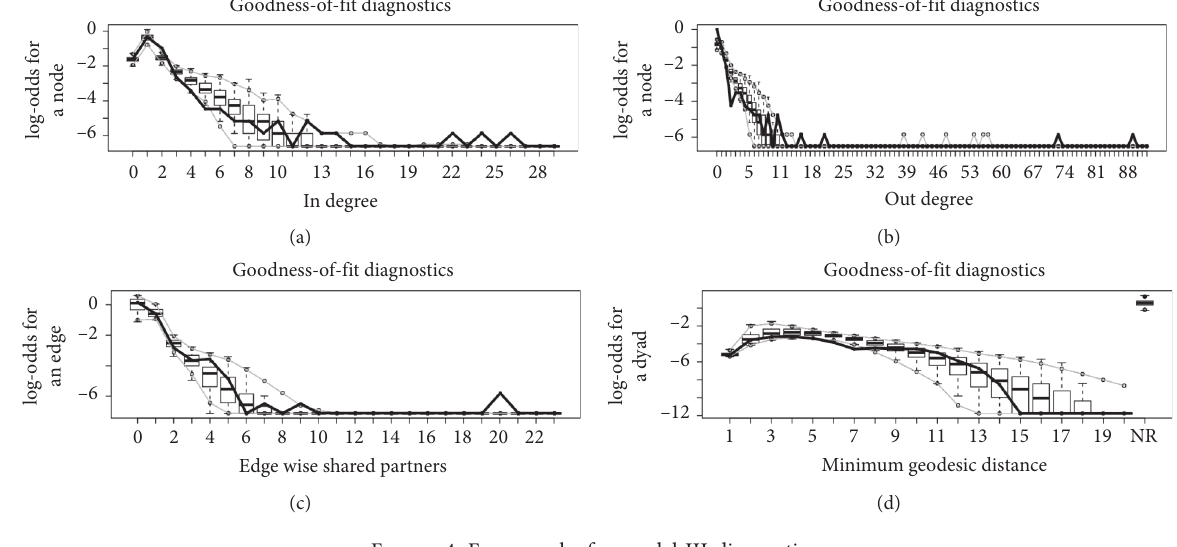
Figure 4: Four graphs for model III